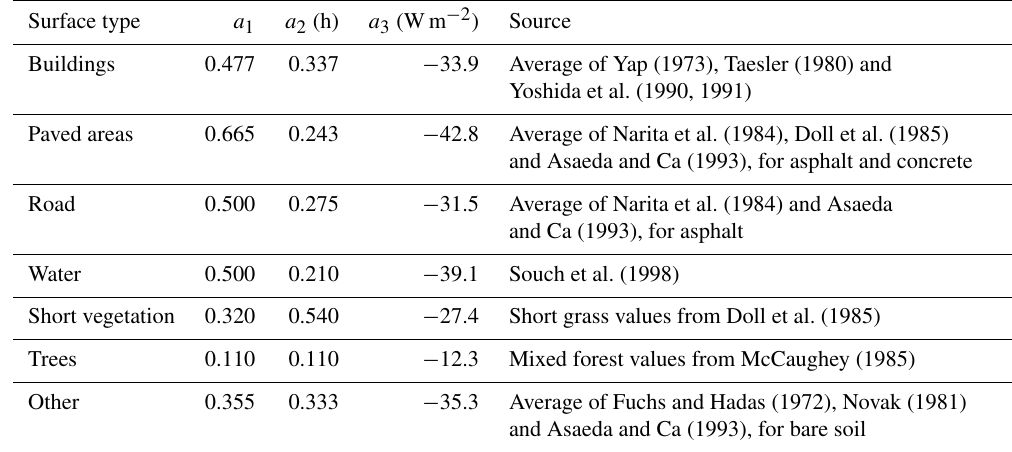
Table C1. Coefficients for each surface type used in the Objective Hysteresis